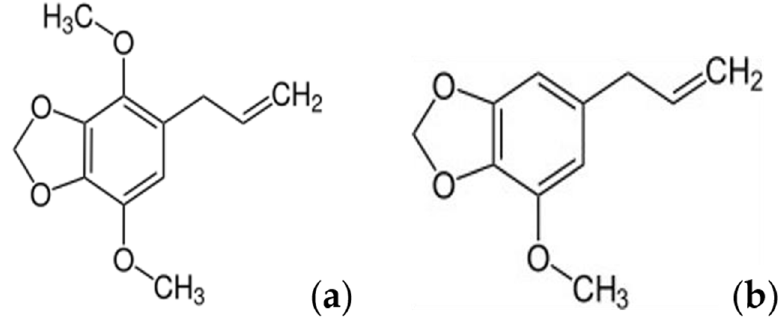
Figure 1. Molecular structure of the compounds apiole ( a ) and myristicin ( b ).